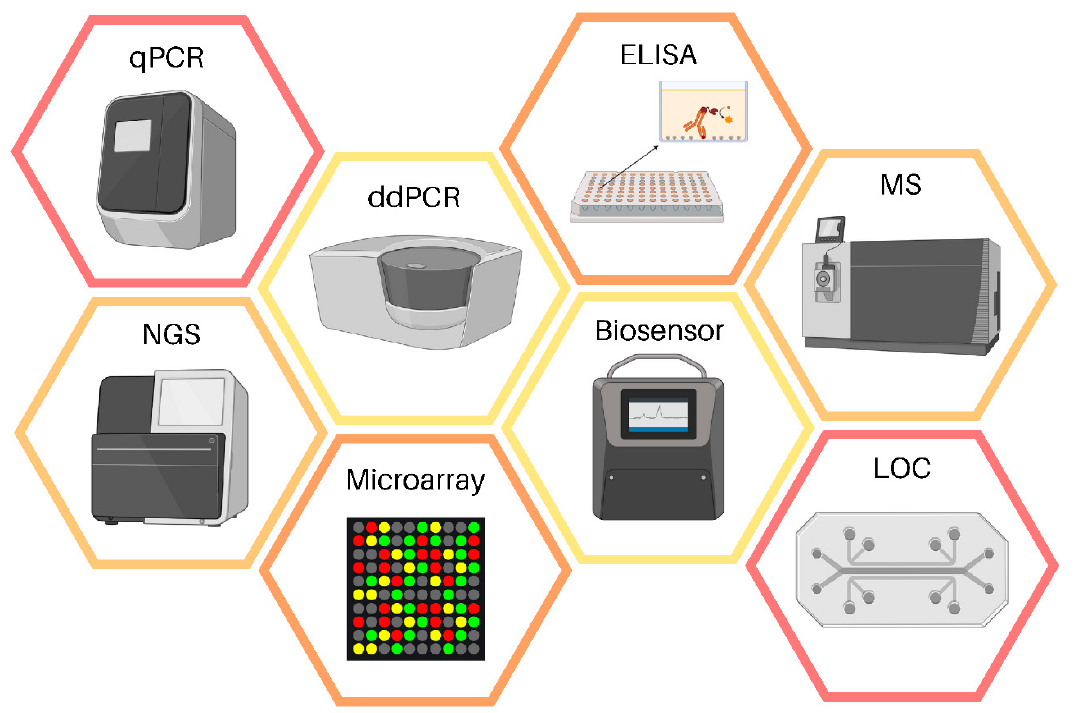
Figure 2. Platforms for the analysis of liquid biopsy samples. Abbreviations: qPCR—quantitative real ‐ time polymerase chain reaction; ddPCR—droplet digital PCR; NGS: next generation sequencing; ELISA: enzyme ‐ linked immunosorbent assay; LOC—lab ‐ on ‐ a ‐ chip; MS—mass spectrometry.